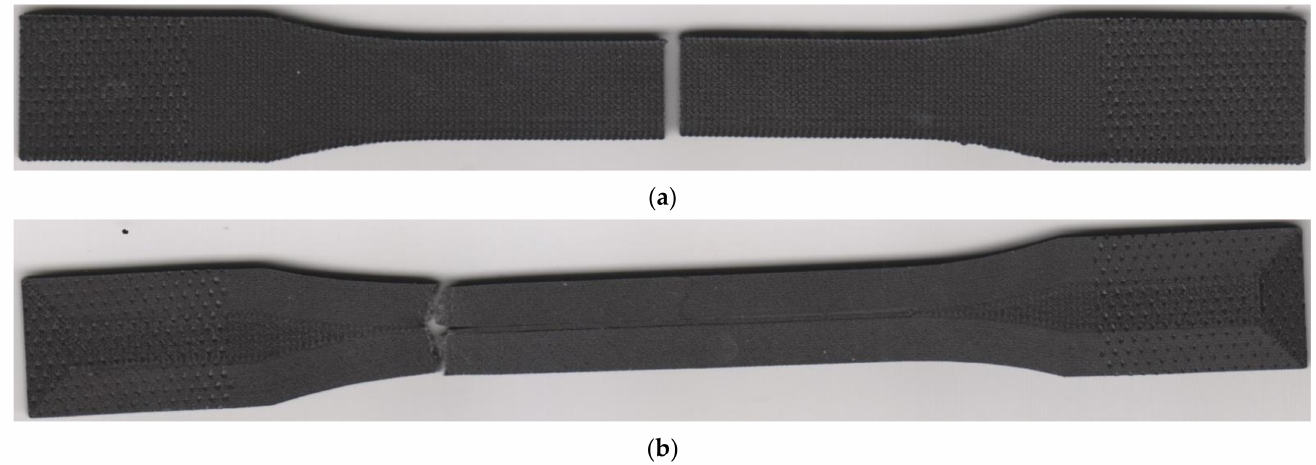
Figure 19. Fractured specimens: ( a ) without walls (theta series); ( b ) with 15 walls (zeta series).